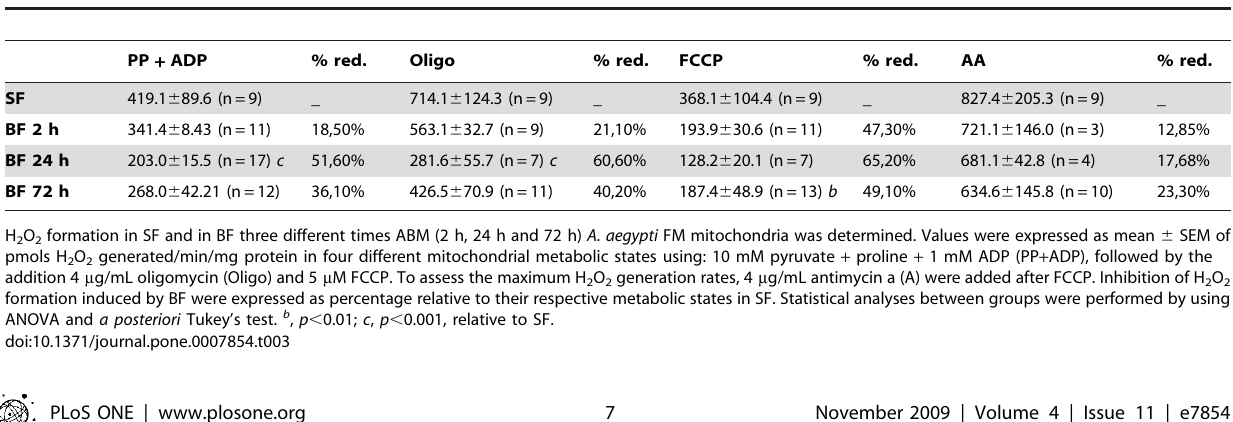
Table 3. Rates of hydrogen peroxide generation in FM mitochondria from SF and BF A. aegypti along the blood digestion process oxidizing pyruvate and